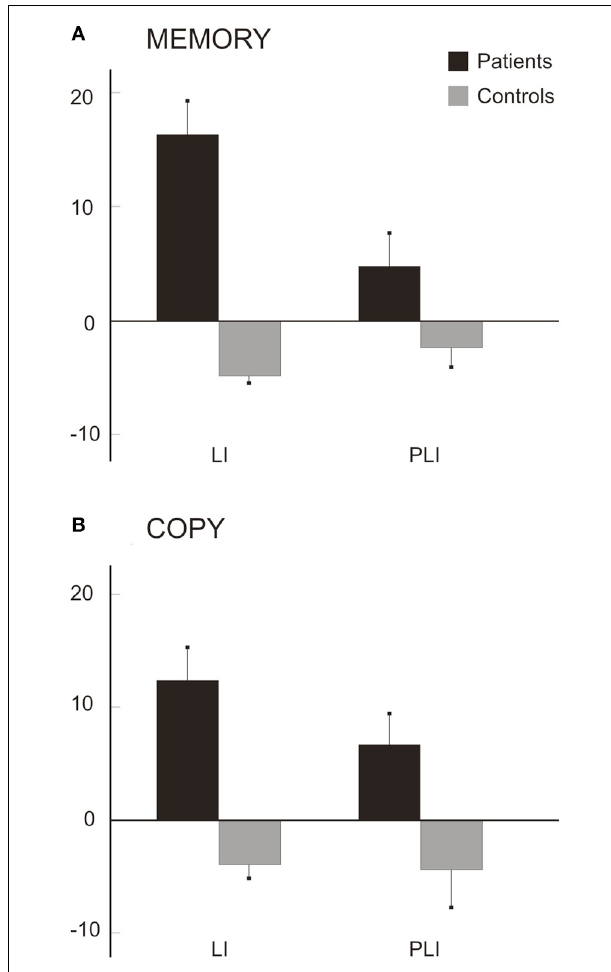
FIGURE 6 | Scores for daisy drawings from memory (A) and by copy (B). Mean LIs (s.e.m.) for drawn areas and mean PLIs (s.e.m.) for number of petals in the seven patients and six control